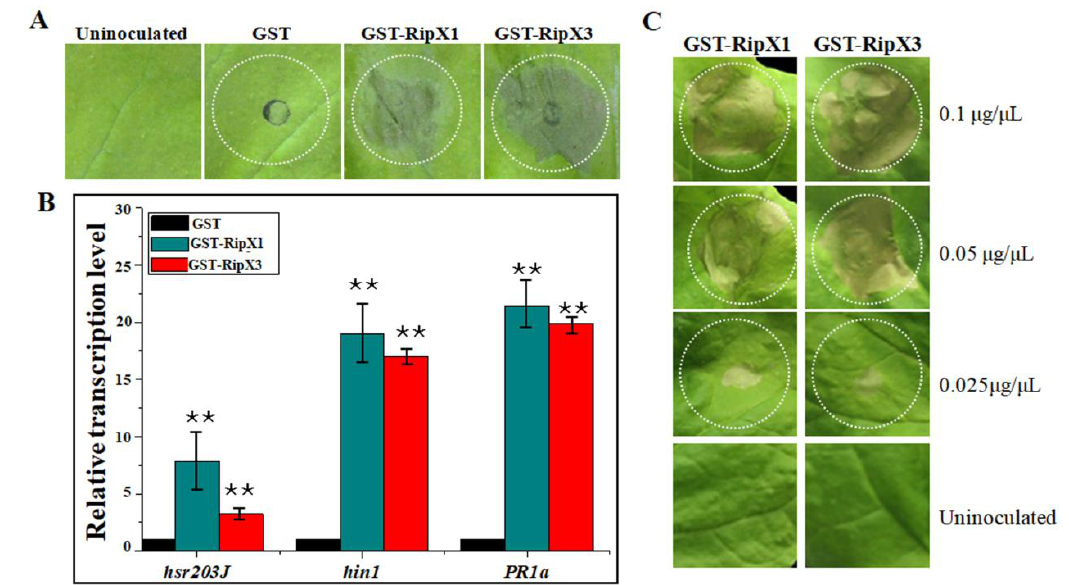
Figure 2. HR reactions induced by RipX1 and RipX3 proteins. ( A ) Macroscopic HR reaction induced by GST-RipX1 or GST-RipX3. A GST tag was used as a negative control. ( B ) Activation of the defense genes hsr203J , hin1, and PR1a examined by qRT-PCR analyses. The expression level for each gene in plants transformed with empty vector pHB was set to 1, and the level in other samples was calculated relative to that. Error bars indicate standard deviations of three individual replicates, and asterisks denote statistical significance (** p ˂ 0.01). ( C ) Identification of the minimum concentration of the RipX protein essential for HR induction. All experiments were repeated three times.